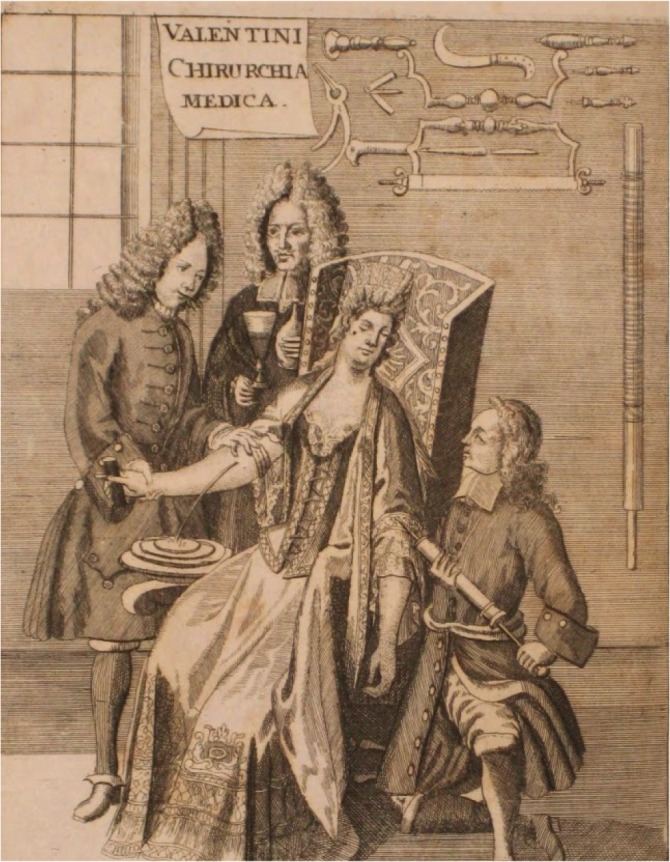
Bloodletting in a female patient, engraving 18th century.